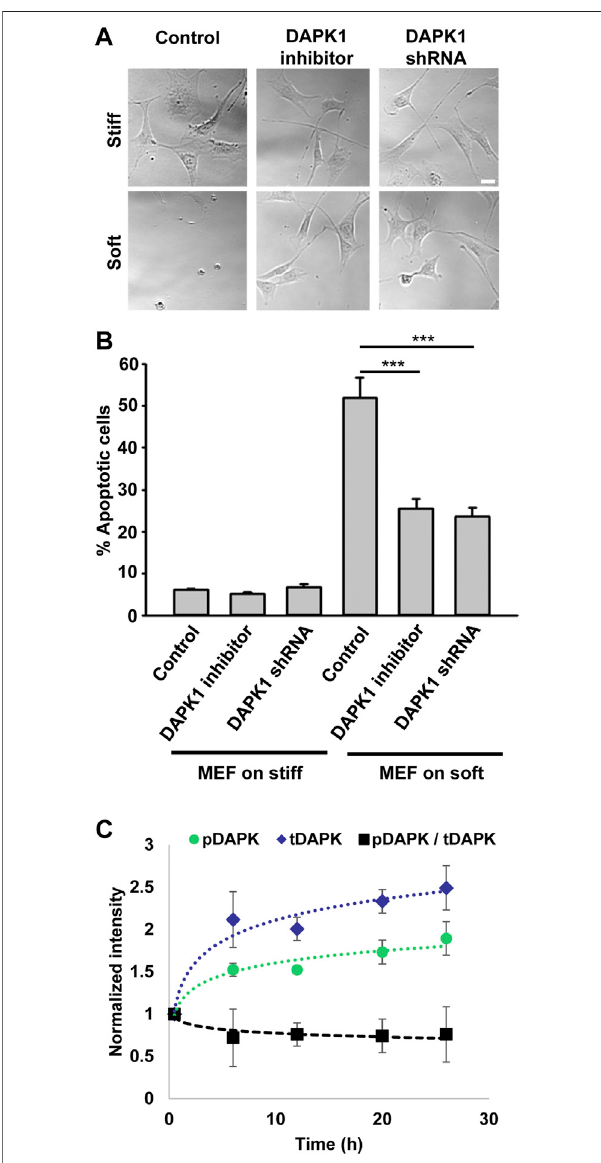
FIGURE 1 | Inhibition of DAPK1 contributes to cell growth on soft matrices. (A) Bright fi eld images of MEFs with DAPK1 inhibitor or stable DAPK1 shRNA MEFs on stiff or soft surfaces. Scale bar: 25 μ m. (B) MEF cells with DAPK1 inhibitor or stable DAPK1 shRNA MEFs were incubated in culture for 1 day on soft or stiff surfaces. Apoptotic cells were identi fi ed for appearance of apoptotic morphology including membrane blebbing and cell rounding. Live cells retained their normal spread morphology. Graphs represent means ± SEM of at least two independent experiments. *** p < 0.001. (C) MEF cells were plated on 0.2 kPa gels and the levels of pS308 DAPK1 (pDAPK) and total DAPK1 (tDAPK) were monitored by double immunostaining of the cells over time. Graphs represent means ± SD. Experiment was repeated twice. *** p < 0.001.